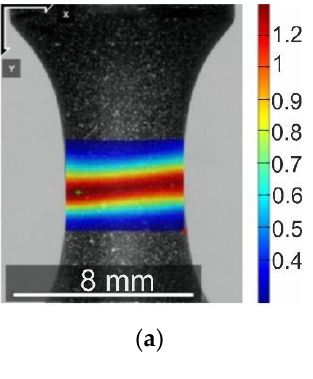
Figure 3. ( a ) experimental sample ODIC image, ( b ) force P versus true strain e and ( c ) general appearance of pre-strained samples.